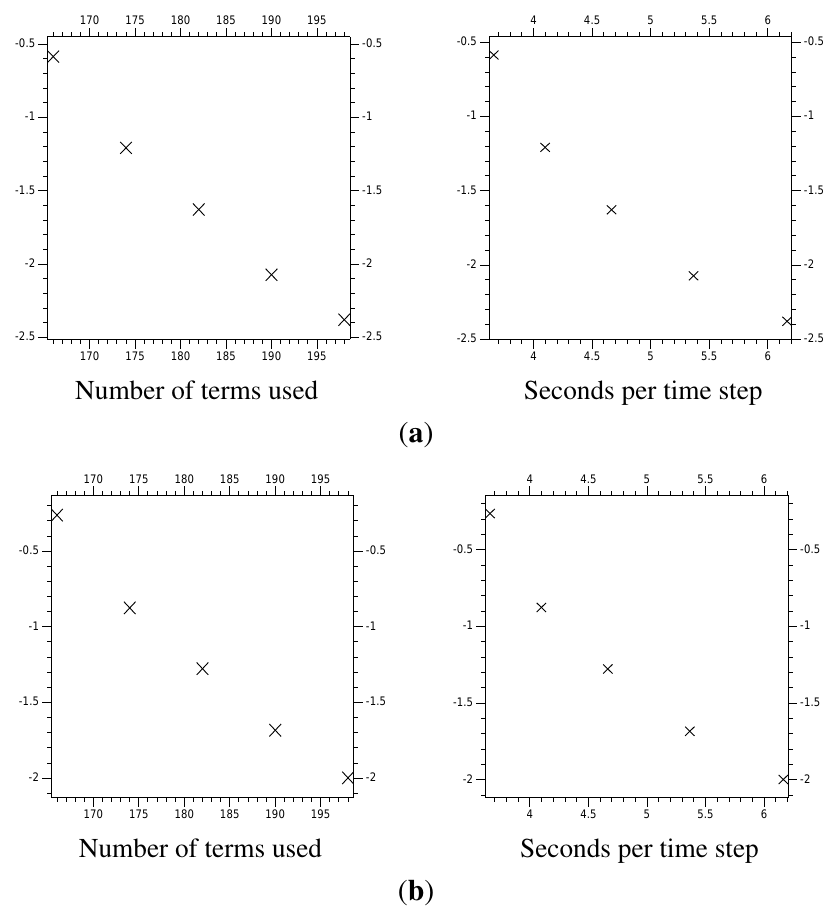
Figure 18. The error at t = 50 of the function Z from the non-linear ( ϵ = 0 . 01 ) problem. The vertical axis is the log of the error, the difference between the V − 10 results and the V − control results (see Figure 15). The horizontal axis is the total number of 4 a and b coefficients used for the y directional decomposition. ( a ) log j;k j;k ( b ) log of the L 1 error; ( c ) log of the L ∞ 10 10